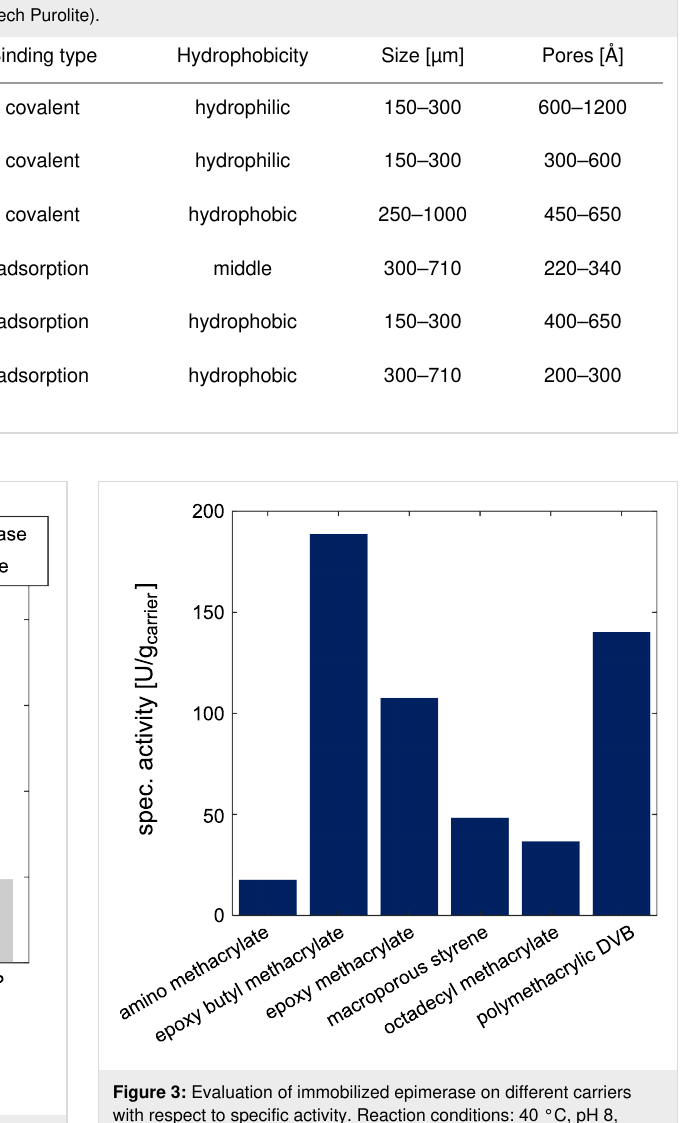
Figure 2: Enzyme loading after immobilization of the epimerase and aldolase on different carriers.